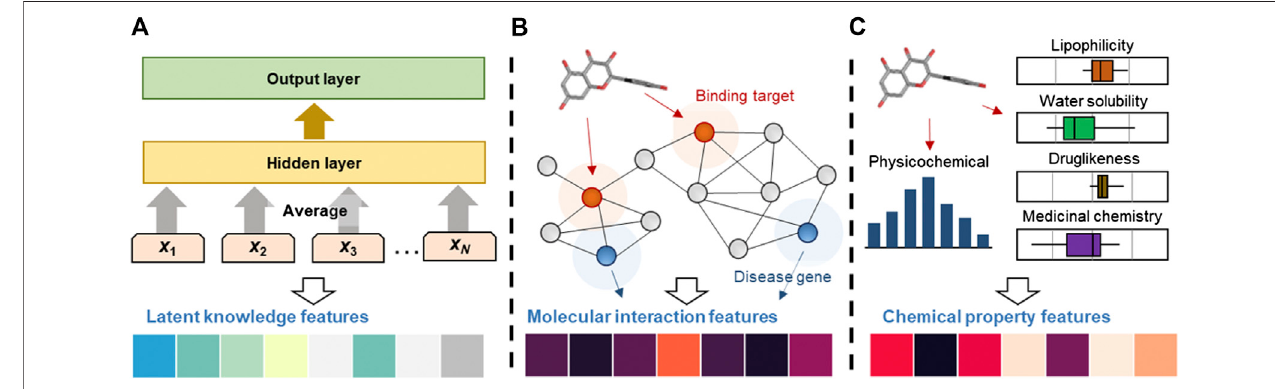
FIGURE1| Computational processes forthe generationoflatent knowledge,molecular interaction and chemicalproperty features. (A) Latentknowledgefeatures were obtained by applying the text mining method to the PubMed abstracts. The n-gram features (x1, ... , xN) are embedded and averaged to fore the hidden variable. (B) Molecular interaction features were generated by applying RWR algorithm to the PPI network. The RWR algorithm propagated compound effects from seed nodes (binding information, red circles) to their neighbors, recursively. (C) Chemical features, including physicochemical properties, lipophilicity, water solubility, pharmacokinetics, druglikeness and medicinal chemistry information, were calculated.